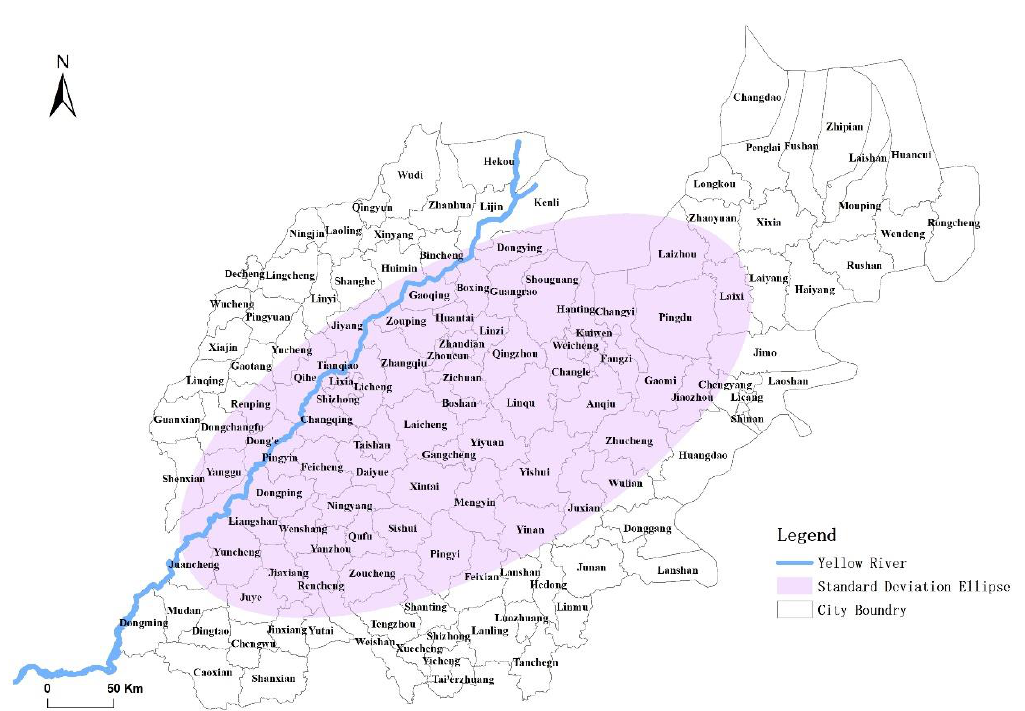
Figure 4. The analysis results of cold and hot spot analysis of ICH in Shandong Province.